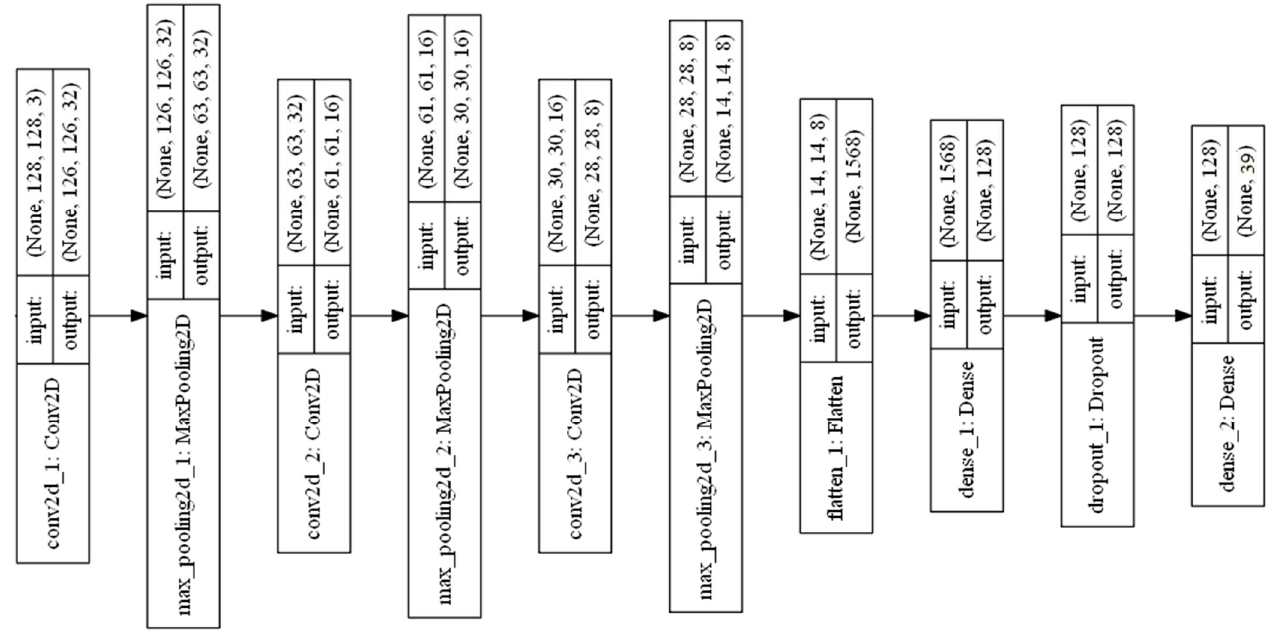
Figure 10. Layered structure of Conv-3 DCNN model.